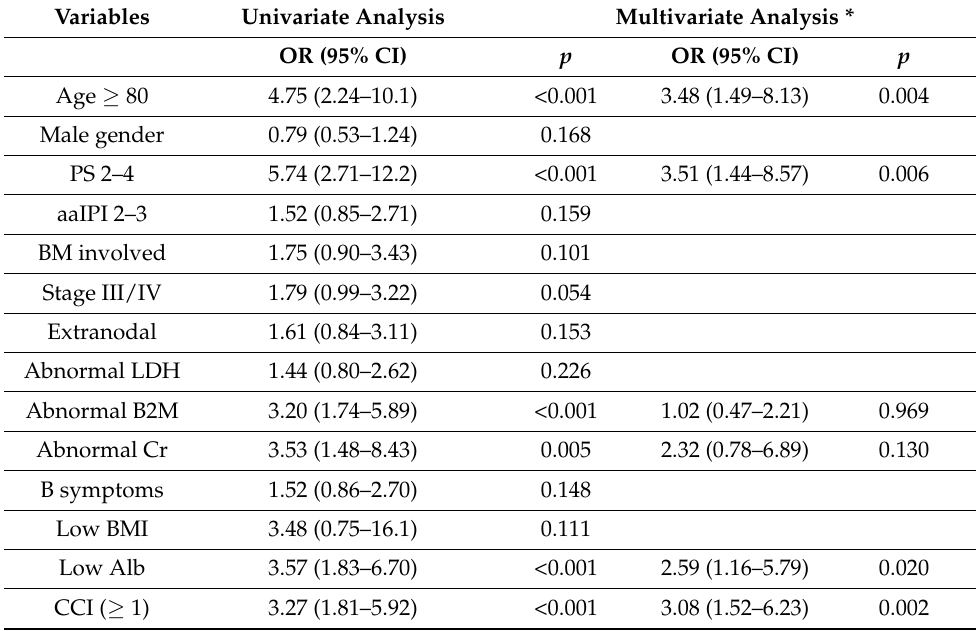
Table 3. Factors associated with receiving non-R–CHOP